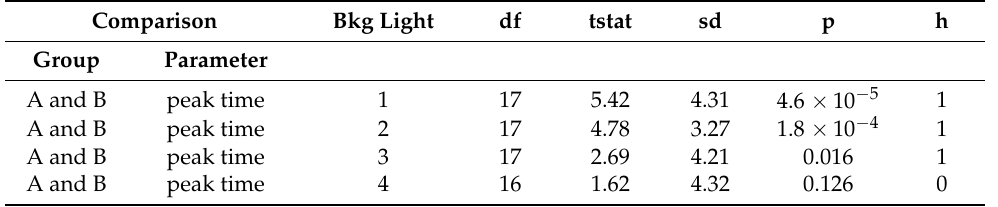
Table A1. Two way ANOVA table, comparing peak times and peak values in abiotic stress experi- ments. A, B, and C: lettuce ‘a’, reference, salt-, and drought-stressed plants. D, E, and F: lettuce ‘b’, reference, salt-, and drought-stressed